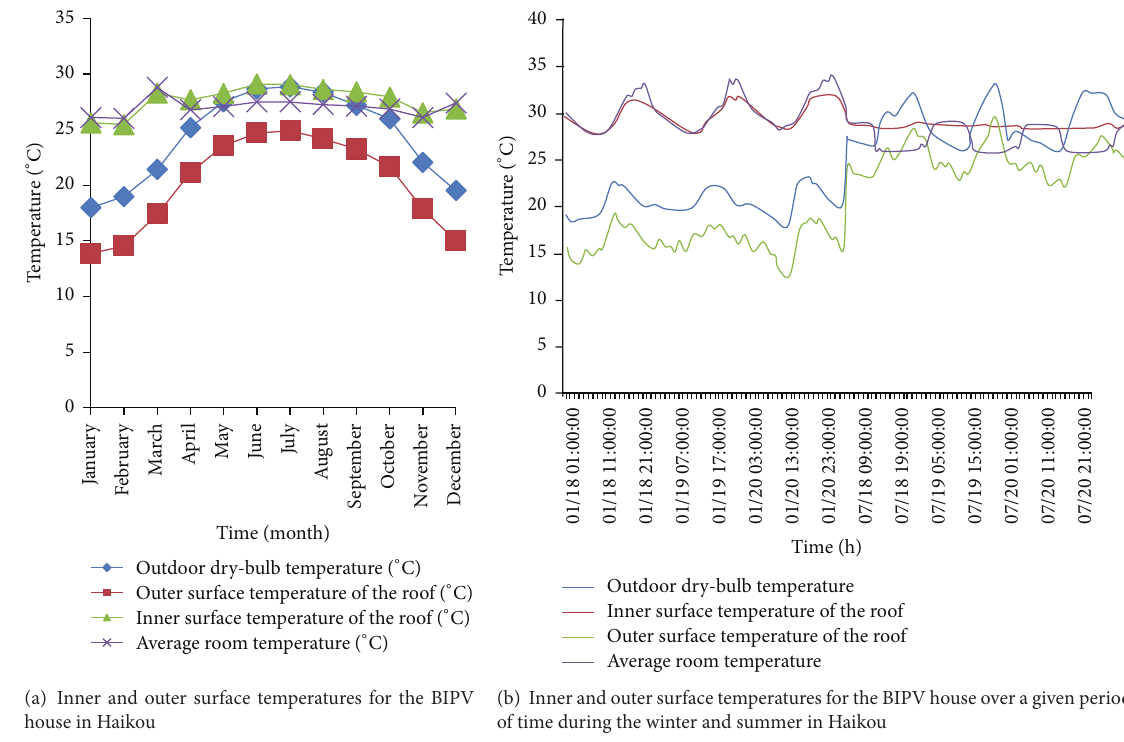
(b) Inner and outer surface temperatures for the BIPV house over a given period of time during the winter and summer in Haikou Figure 14: Simulated inner and outer surface temperatures for the BIPV house in Haikou.